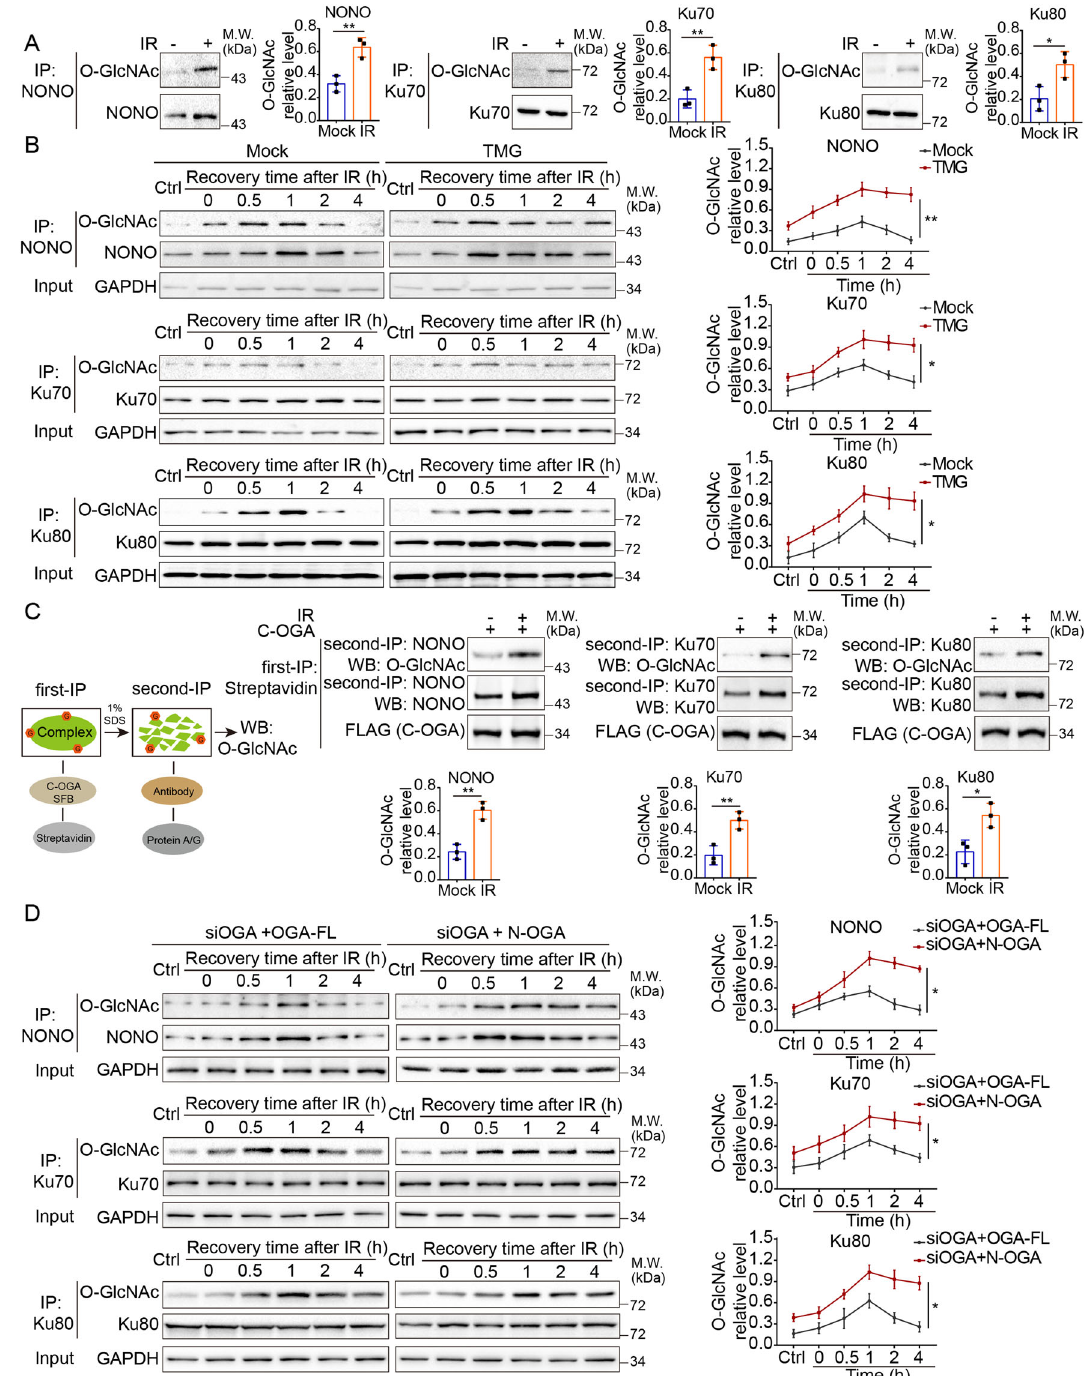
Fig. 4 OGA mediates deglycosylation of NONO and the Ku70/80 complex. A The O-GlcNAcylation of NONO and the Ku70/80 complex were induced in response to DNA damage. 293T cells were treated with 10 Gy of IR and after 1 h cells were lyzed with NETN300 buffer. Cell extracts were examined by IP and western blot with indicated antibodies. The histogram shows the relative level of the O-GlcNAcylated NONO, Ku70, Ku80 signal. B Time course analyses of O-GlcNAcylation of NONO and the Ku70/80 complex events with mock or the TMG treatment following IR treatment using Western blotting. 293T cells were treated with mock or TMG and then exposed to 10 Gy of IR. Cell extracts were examined by IP and western blot with indicated antibodies. C The HAT domain of OGA recognizes O-GlcNAcylated NONO and the Ku70/80 complex following DNA damage. 293T cells were transfected with SFB-C-OGA and then two-step Co-IP assay was performed. Streptavidin beads were used to bind the HAT domain of OGA (C-OGA) partners in the fi rst Co-IP assay. Anti-NONO, anti-Ku70/80 antibodies were used to IP target proteins in the second Co-IP assay. Western blot assay was performed with indicated antibodies. D Time course analyses of the deglycosylation of NONO and the Ku70/80 complex by full-length OGA or N-OGA following IR treatment using western blot. Cells were treated with siOGA and rescued with FL OGA or truncated OGA. Then these cells were exposed to 10 Gy of IR. Cell extracts were examined by IP and western blot with indicated